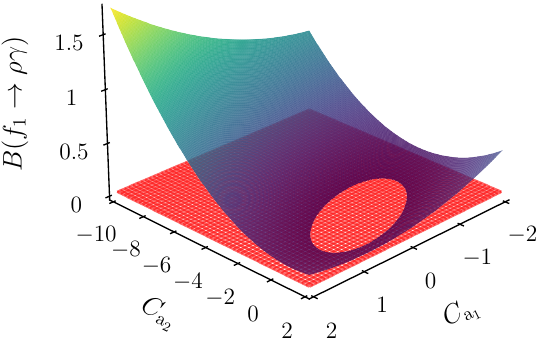
Figure 6 . Surface plot of B ( f 1 → ργ ) ( blue-yellow textured ), equation (4.26), using the central value of C s = 0 . 93(11) , equation (4.24), together with the central value of B ( f 1 → ργ ) = 4 . 2(1 . 0)% ( red ), see section